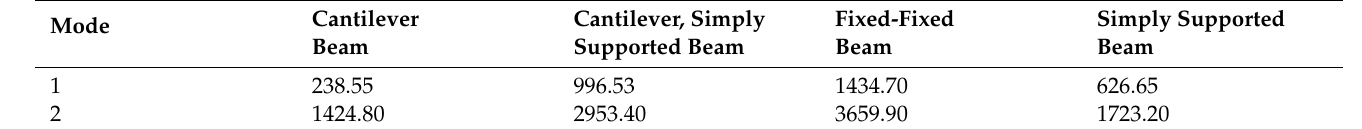
Table 1. The first two natural frequencies of intact beams for different boundary conditions in Hz.